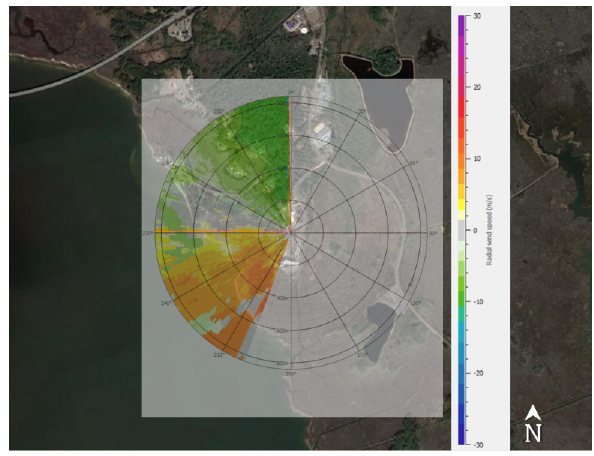
Figure 5: PPI scan with 25m range gate showing radial wind speed up to a 900 m range.